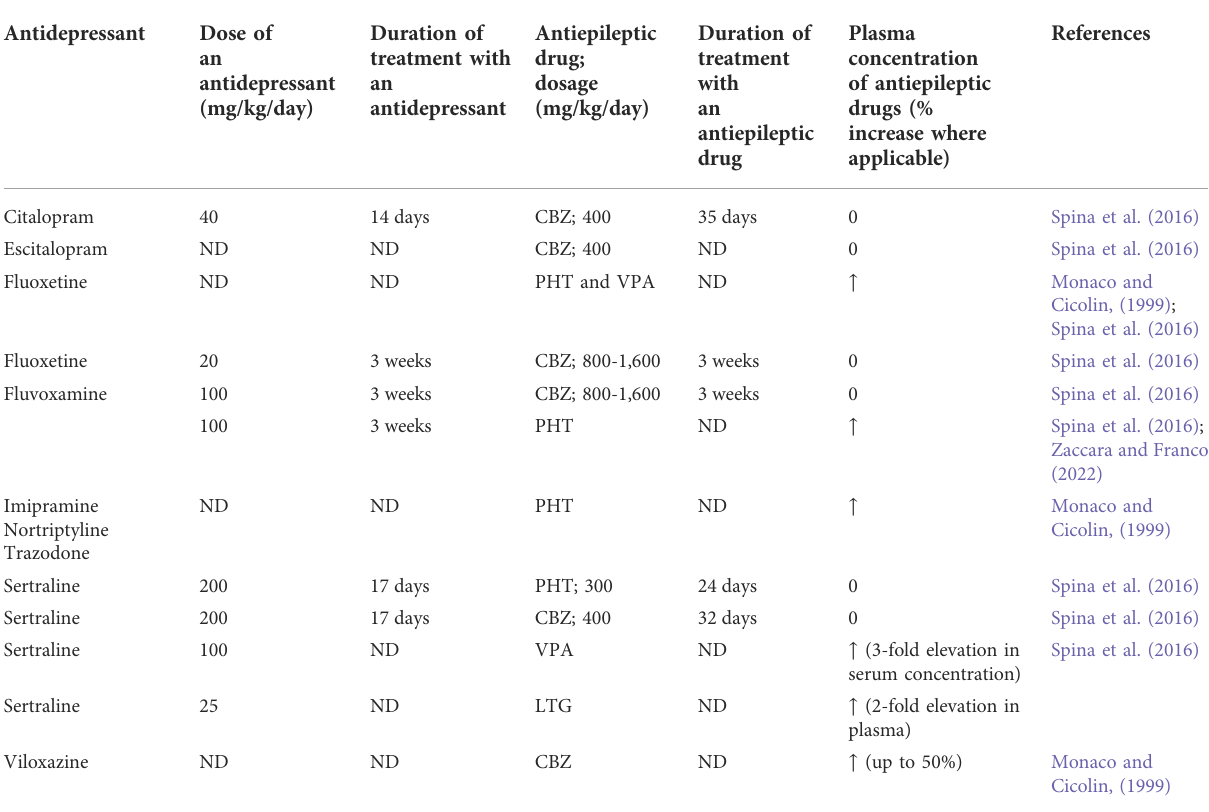
TABLE 4 Pharmacokinetic interactions between antidepressant and antiepileptic